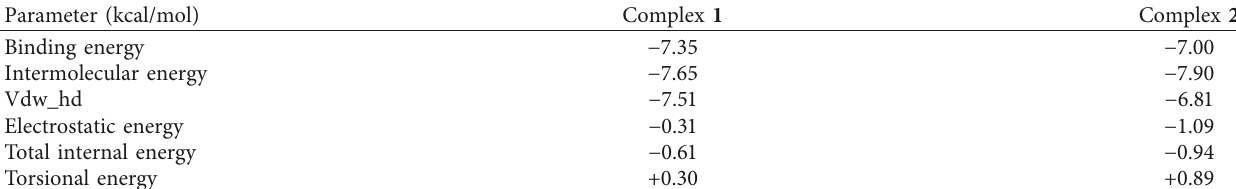
∆ G intermol ) of complexes 1 and 2 with DNA.